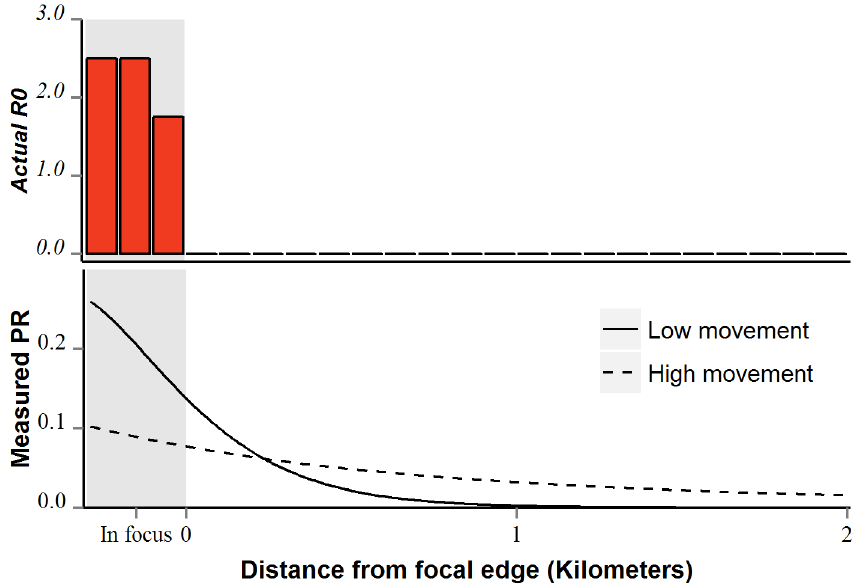
Fig 1. Hypothetical observed fraction of people infected with malaria (parasite rate) within and near malaria foci. Transmission only occurs within focal areas (top panel). Observed parasite rate shown in bottom panel with varying distances travelled. As humans move further and/or more frequently from within focal areas, they export parasites, causing larger extra-focal extents to exhibit nonzero parasite rate (dotted line; bottom